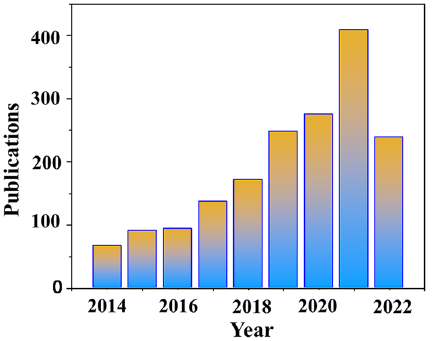
Fig. 1 The statistics of publication on EFWSs in recent